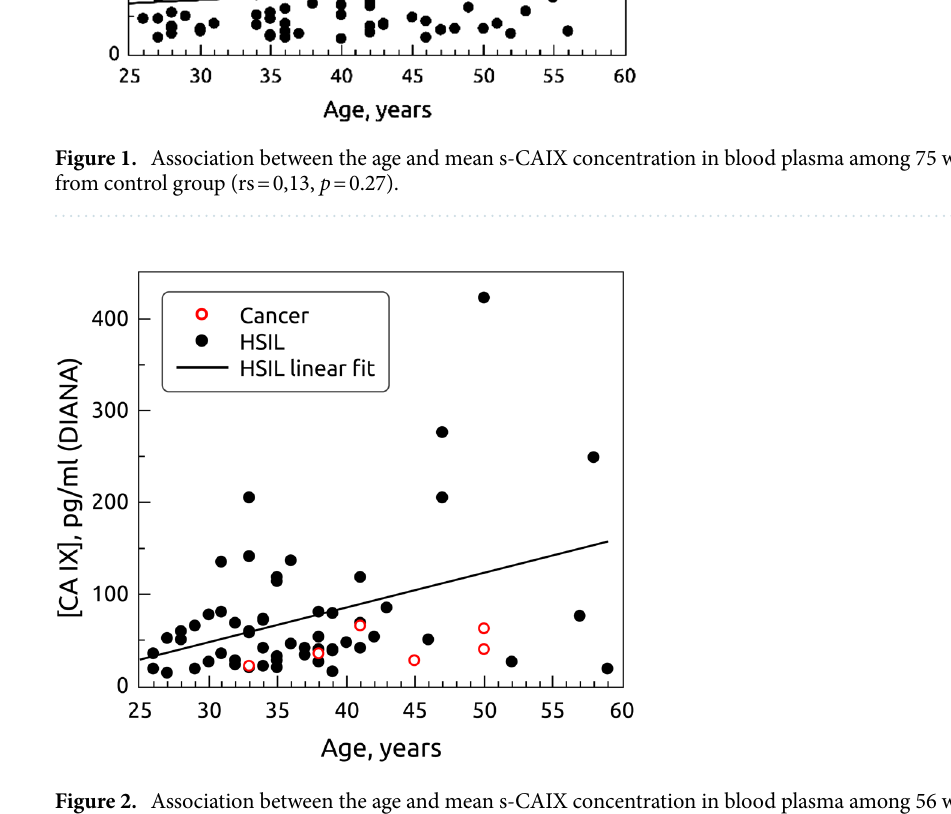
Figure 2. Association between the age and mean s-CAIX concentration in blood plasma among 56 women with HSIL (rs = 0,27, p =